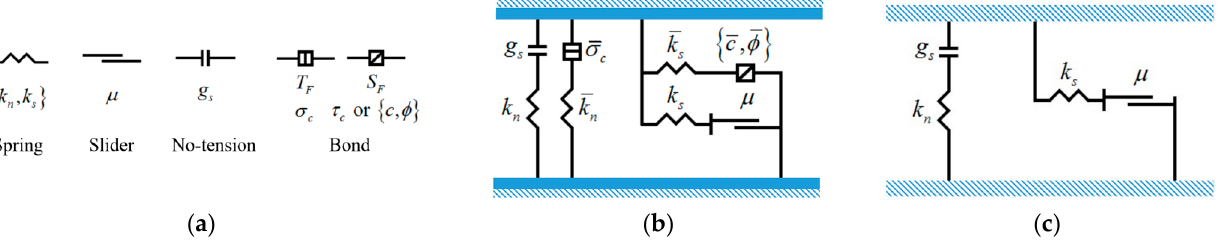
Figure 5. Contact rheological components ( a ) of the linear parallel-bond model ( b ) and the linear contact model ( c ).